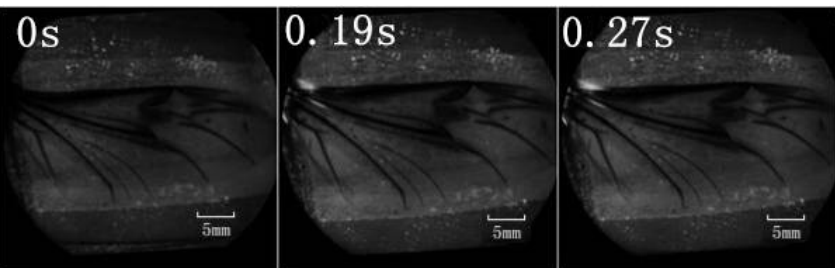
Figure 4. Fluorescence flow sequence of wing unfolding in Dorcus titanus platymelus